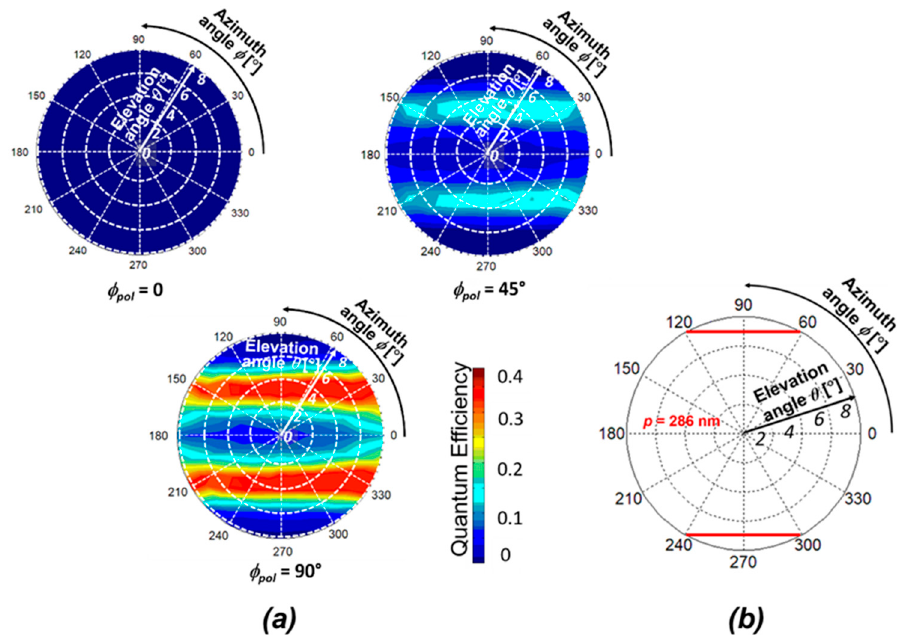
Figure 7. ( a ) Measured spatial patterns in SOI PD with a 1D L/S SP antenna for different polarizations (i) φ pol =0, 45 ° and 90 ° ; ( b ) theoretical spatial pattern of peak incident angle based on phase matching condition to verify the measurements reproduced from [22]. The grating period was fixed at p = 286